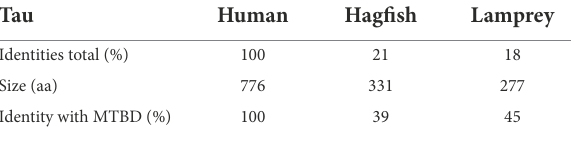
TABLE 4 Analysis of MAPT in jawless fish. Tau Human Hagfish Lamprey